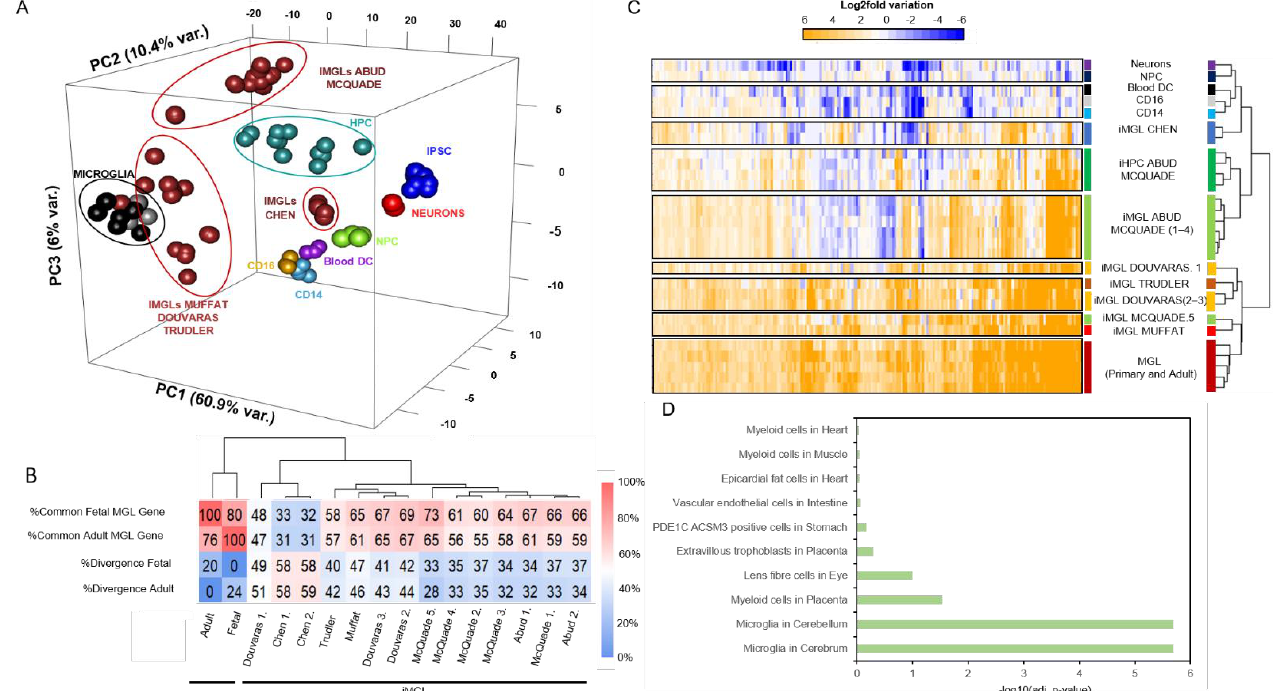
Figure 3. Differences and similarities between the iMGL gene expression profiles issued from six differentiation protocols. ( A ) Three-dimensional principal component analysis (3D PCA) showing iMGL in dark red, in vivo microglia (fetal and adult microglial cells in black and grey, respectively), induced hematopoietic progenitor cells (iHPC) in azure, CD14+/CD16− quiescent monocyte in green, CD14+/CD16+ inflammatory monocytes in yellow, blood dendritic cells in violet, neurons in red, and IPSC in blue. The first principal component (PC1 60.9% variance) represents the hematopoietic differentiation process, principal component 2 (PC2 10.4% variance) allows the separation of the in vivo microglia cells and the iMGL datasets, and principal component 3 (PC2 6% variance) allows the discrimination between the different monocytic population trajectories. The PCA graph reveals the stratification of all iMGL samples on three major clusters. The first cluster is composed by iMGL samples issued from protocols developed by Muffat et al., Douvaras et al., and Trudler et al. and presents a striking similarity with the in vivo microglia control samples. The second cluster, separated from the first cluster because of PC2, is composed by iMGL samples issued from protocols developed by Abud et al. and McQuade et al. Finally, the third cluster present in the monocytic region of the graph presented the iMGL samples generated by Chen et al. ( B ) Similarity and divergency matrix (in percent) for each of the iMGL datasets compared to the control microglia samples. This analysis is based on the upregulated genes (2-fold change; adjusted p -value < 0.01) assessed in each of the iMGL samples relative to the corresponding induced pluripotent stem cell (iPSC) precursor samples. ( C ) Gene expression levels (log2 fold-change, Euclidian clustered heatmap) assessed on iMGL and the corresponding control samples on a subset of 201 microglia-specific genes. ( D ) Cell ontology of the 201 microglia-specific genes.